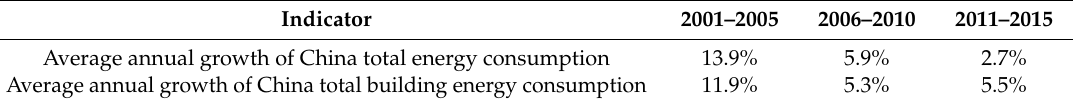
Figure2. China’sBuildingEnergyConsumption2001–2015. (Source:1)Dataontotalenergyconsumption, Figure 2. China ’s Building Energy Consumption 2001 – 2015. (Source: 1) Data on total energy China EBS 2001–2015; (Source: 2) Data on total building energy consumption, primary). consumption, China EBS 2001 – 2015; (Source: 2) Data on total building energy consumption, primary). Table 1. China Energy Consumption growth rate in the three five-year Table 1. China Energy Consumption growth rate in the three five-year periods.